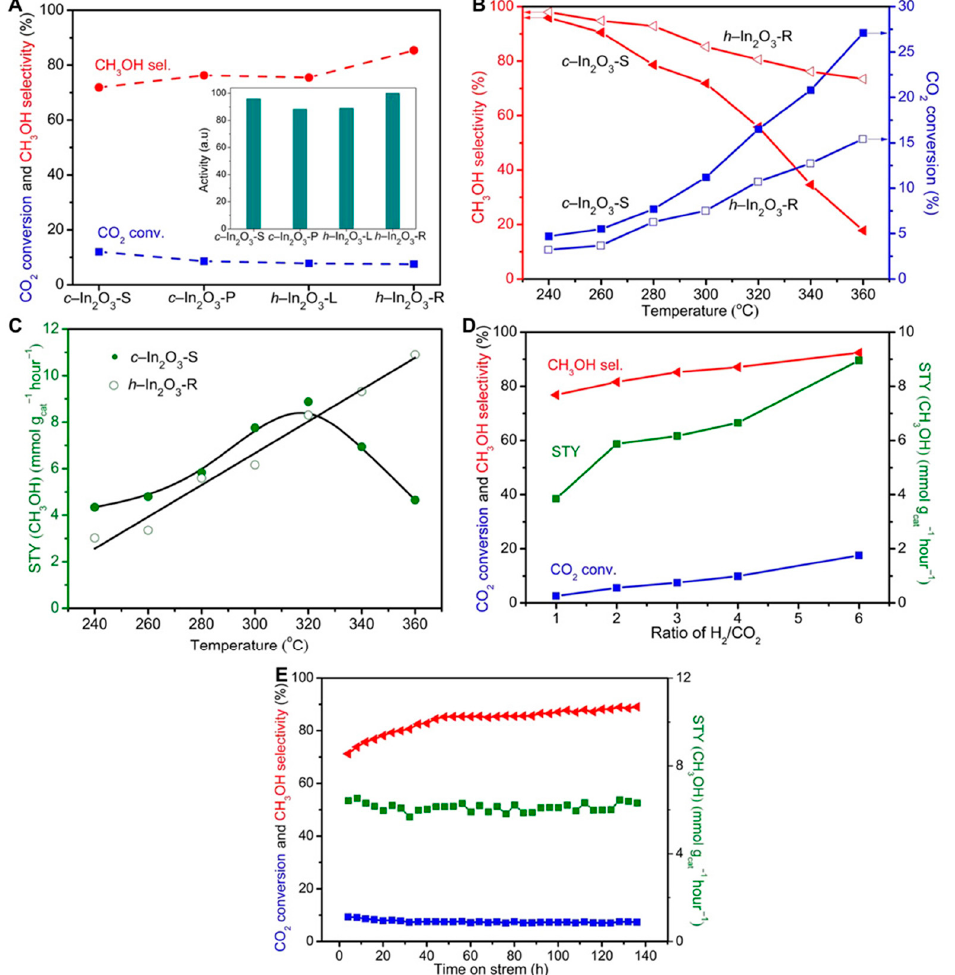
Figure 2. The catalytic activity of di ff erent In 2 O 3 nanomaterials in CO 2 hydrogenation: ( A ) CO 2 conversion and methanol selectivity over In 2 O 3 with di ff erent crystal phases and morphologies. ( B ) Effect of temperature on conversion of CO 2 and selectivity of methanol over c -In 2 O 3 -S and h -In 2 O 3 -R. ( C ) E ff ect of temperature on space-time yield (STY) over c -In 2 O 3 -S and h -In 2 O 3 -R. ( D ) E ff ect of